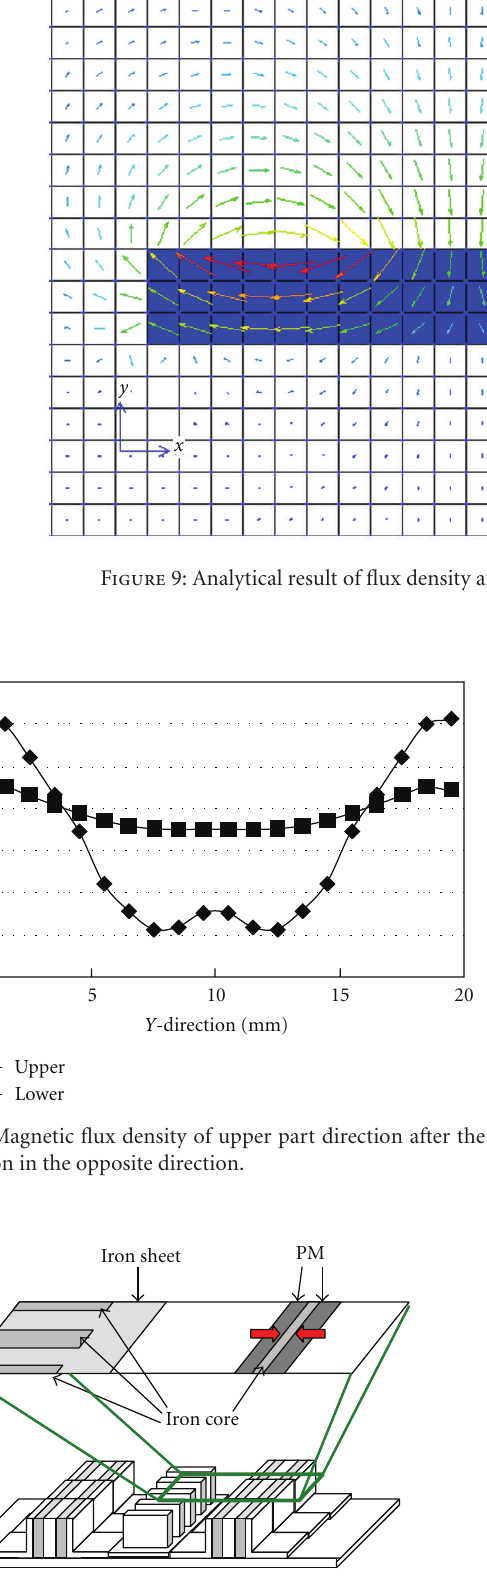
Figure 11: Measurement experiment of magnetic field distribution of magnetic rail.